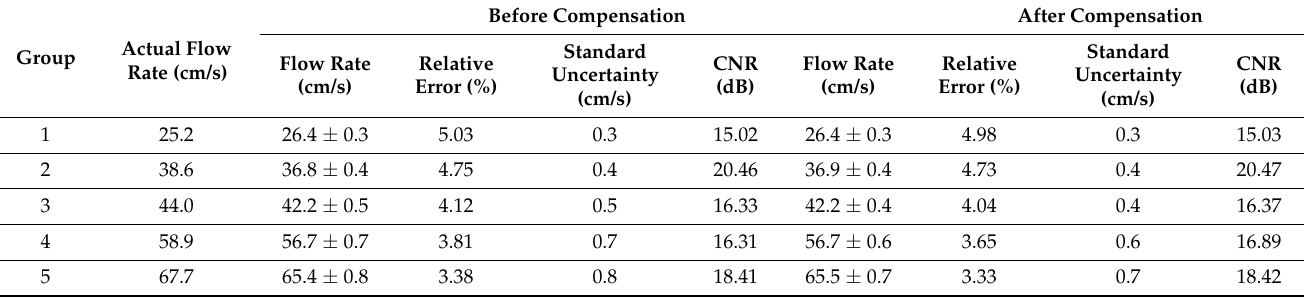
Table 2. Summary of the mechanical scanning high-frequency ultrasound imaging system test